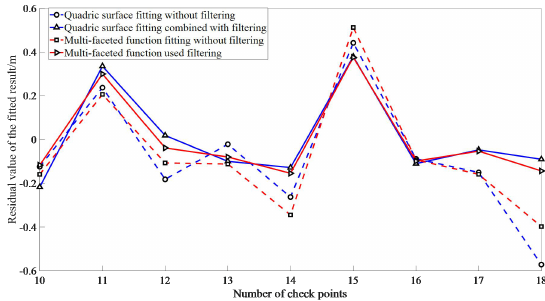
Figure 1. Check results of quadric surface and polyhedral function before and after used filtering It can be seen from Fig.1 that the solid line graph is the improved fitting residual after adding Vondrank filtering, and the two solid lines are close to the place where the residual result is the smallest. Among them, the red solid line is the multi-faceted function plus the improved residual of Vondrank filter, which is also the most stable curve, which is much better than the unfiltered method. The solid blue line is the improved trend of quadratic surface fitting plus Vondrank filtering. This method is slightly lower than the improved multi-faceted function, but much more accurate than when no filtering is used.